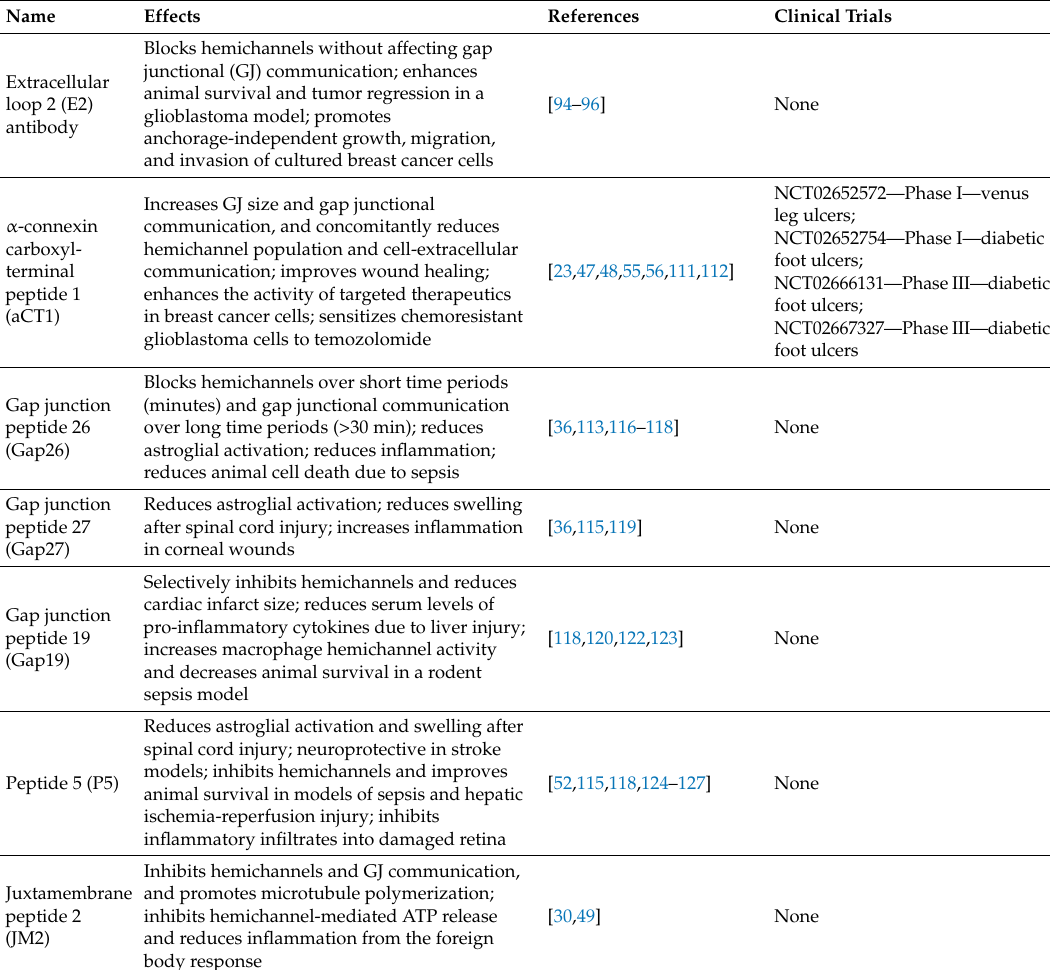
Table 1. Connexin-based